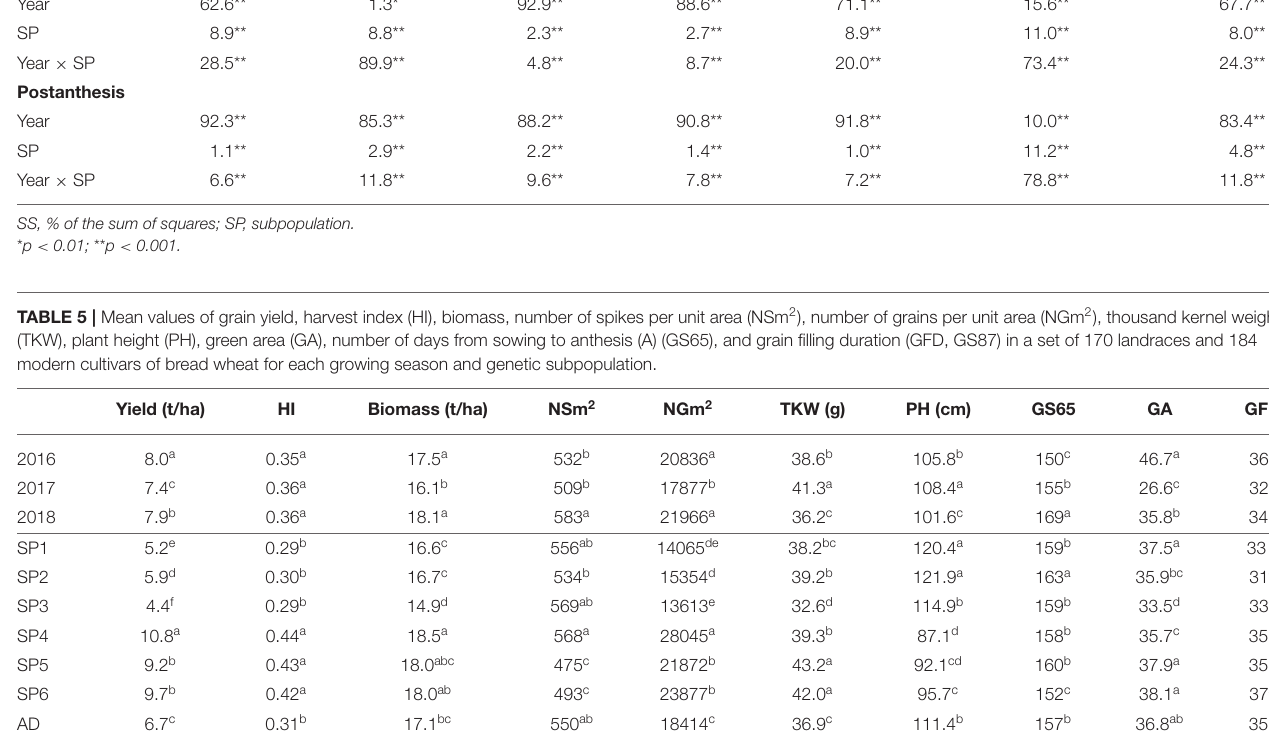
( Table 7 ) and phenotypic performance for landrace and modern sets separately and both sets were combined. The landrace R 2 values ranged from 0.10 for MSAVI_A to 0.39 for GA, while the modern R 2 values ranged from 0.10 for MTVI2_A to 0.64 for GNDVI_A. When the regressions were conducted on the combined data set, the R 2 values ranged from 0.11